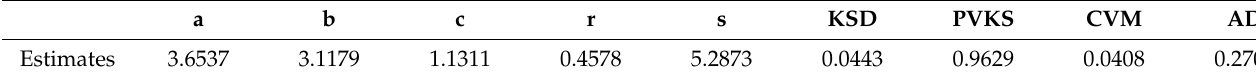
Table 8. ML estimates of the EKW parameters with the corresponding bladder data.